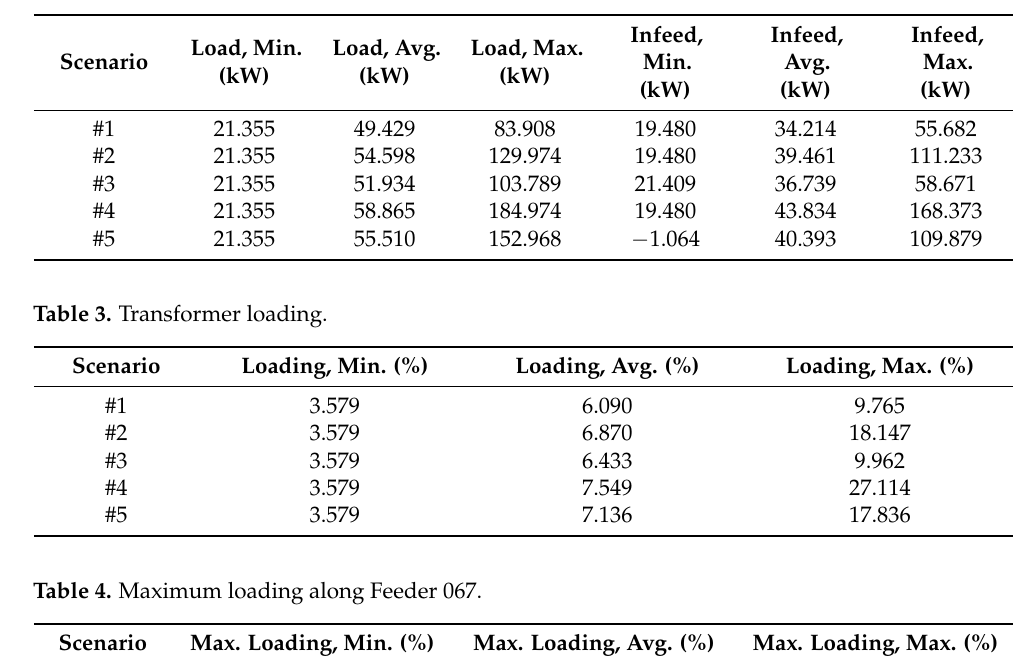
Table 2. Active powers for Feeder 067.